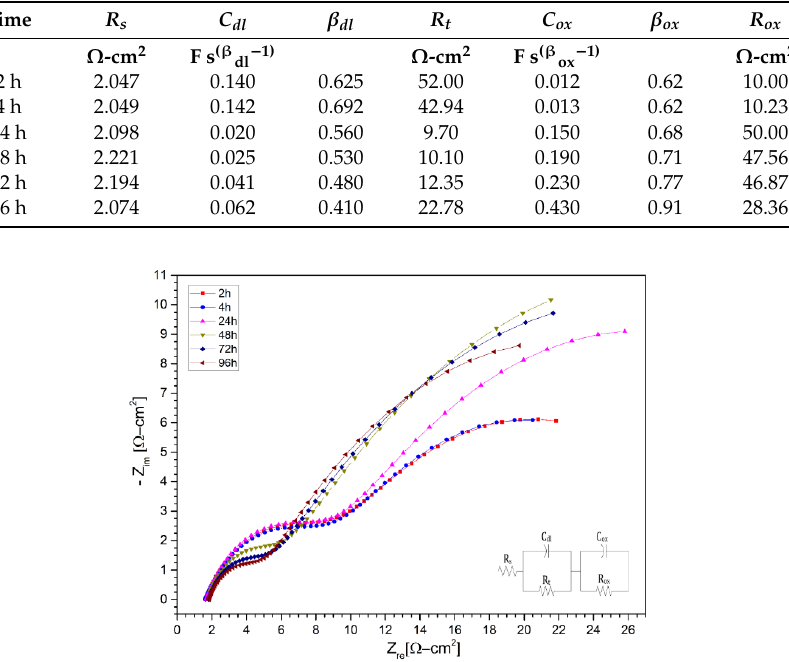
Figure 12. Nysquist diagram of Nickel alloy HR224 layer in (LiNaK)NO 3 (ternary salt with lithium content) at 2 h, 4 h, 24 h, 48 h, 72 h, and 96 h at 550 °C.